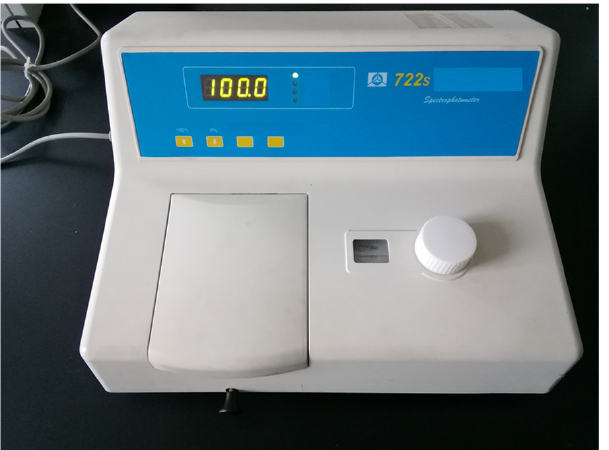
Figure 1. Ultraviolet spectrophotometer.